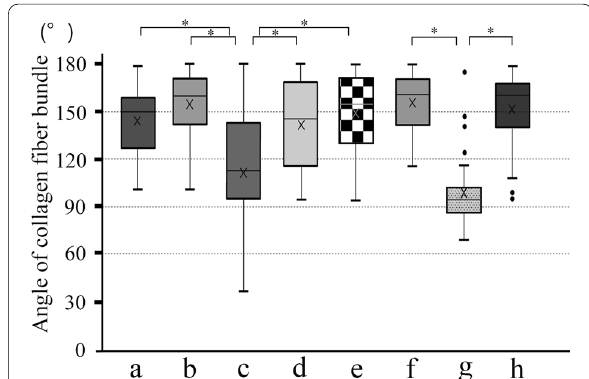
Fig. 5 Angles of orientation of collagen fibers at each location. Box-and-whisker plot of the angle of the collagen fiber bundle with respect to the Y -axis. The vertical axis shows the number of collagen fibers, and the horizontal axis shows the angle with respect to the axis of the implant body set as 0°